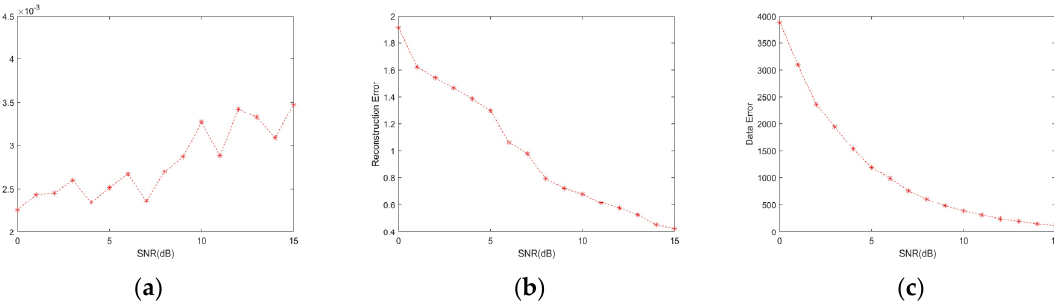
Figure 6. Proposed method performance under different SNRs. ( a ) RMSE of the average of six directions motion errors. ( b ) Target reconstruction error. ( c ) Data error.